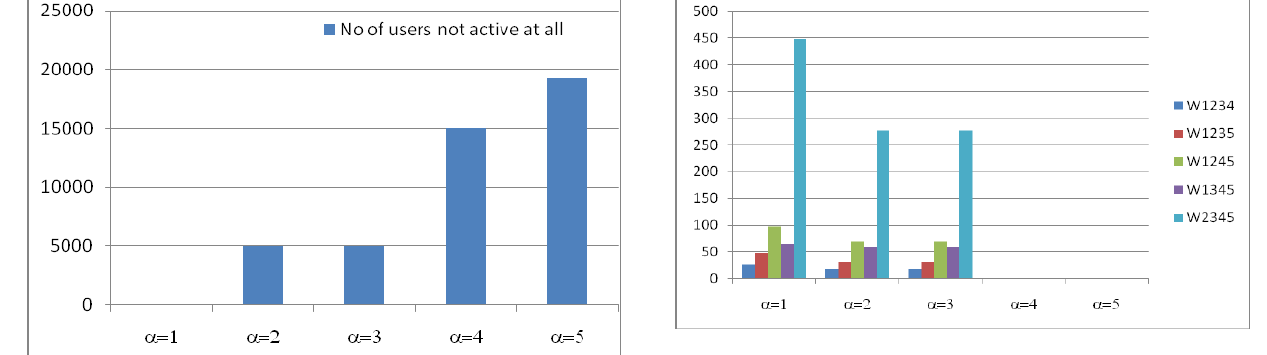
Figure 8 Number of users who are active within four windows out of five depending on α value